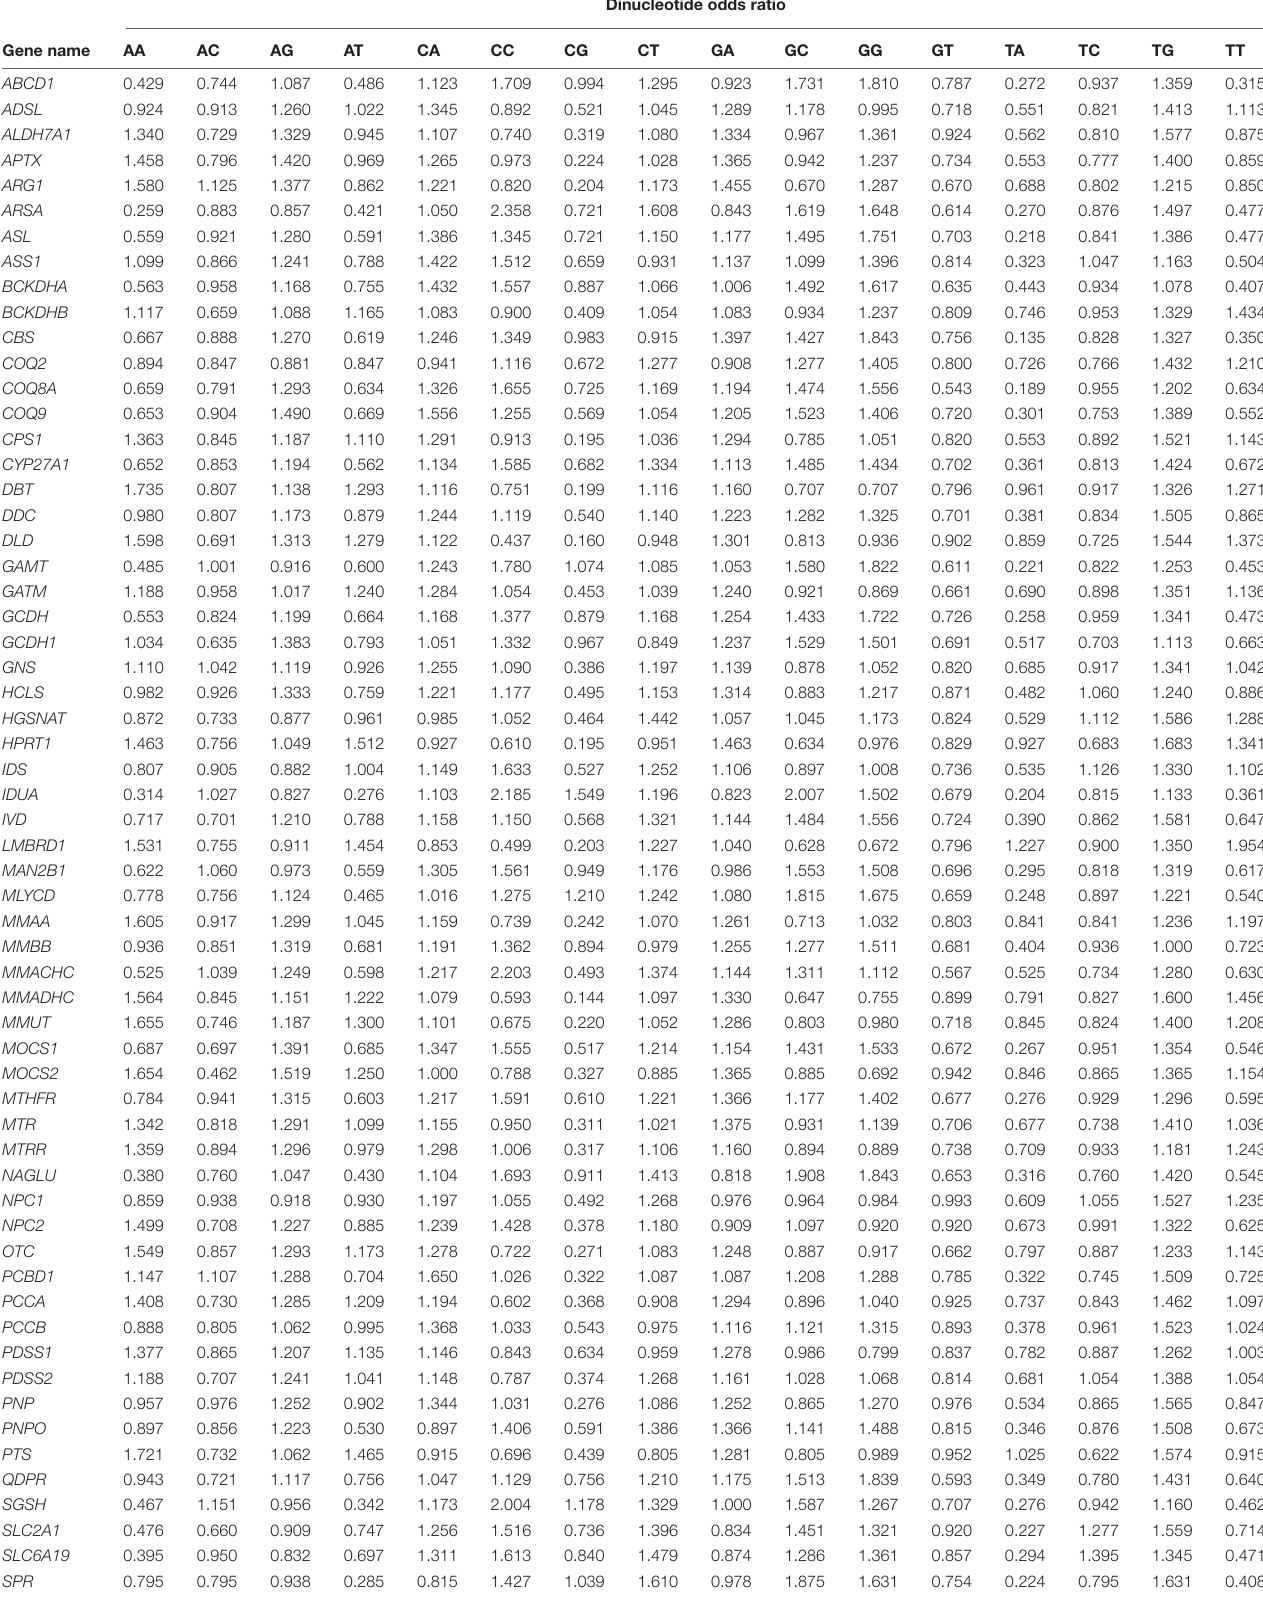
Dinucleotide odds